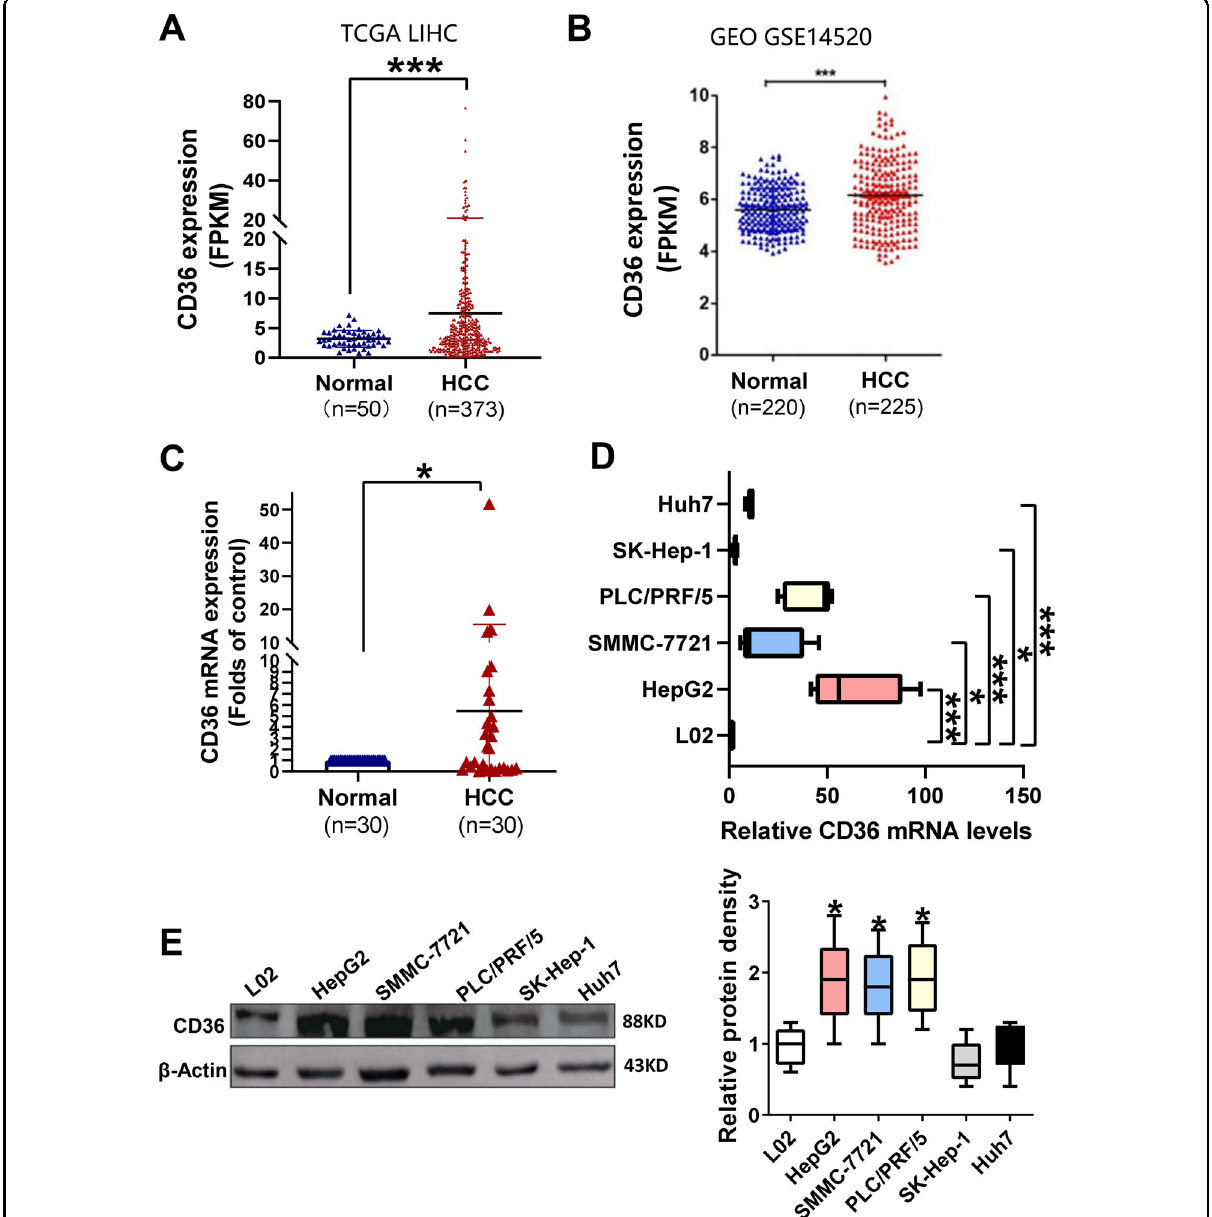
Fig. 1 CD36 levels are increased in human HCC samples and cell lines. The expression of CD36 in 373 HCC samples (including 50 paired normal liver tissues) from TCGA dataset ( A ) and 225 HCC samples (including 220 paired normal liver tissues) from GSE14520 dataset ( B ) was analyzed. C The mRNA levels of CD36 in 30 paired HCC and their paracancerous tissues were examined by RT-qPCR. * P < 0.05, ** p < 0.01, and *** p < 0.01 compared with the normal tissue. The mRNA and protein levels of CD36 in HCC cell lines, named L02, Huh7, SK-hep-1, SMMC-7721, HepG2, and PLC/PRF/5, were measured by real-time PCR ( D , n = 5) or western blotting ( E , n = 3). The densitometric quanti fi cation of the blots with all cell lines was shown in the following. All data are presented as mean ± SD. * P < 0.05, ** p < 0.01, and *** p < 0.001 compared with the L02 cell line. P -value was calculated using Student ’ s t